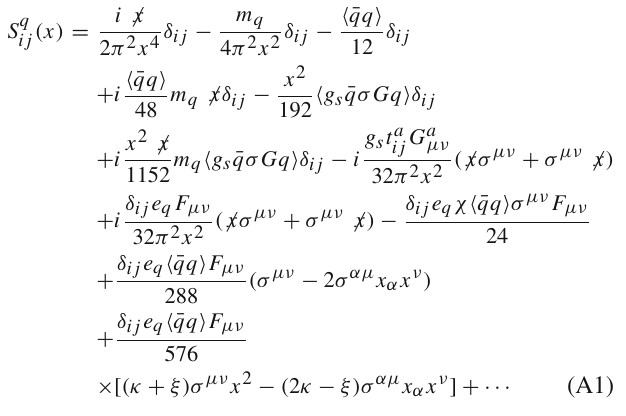
Fig. 2 The dependence of the magnetic moment μ P 7GeV 2 . From the figure we can see that μ P